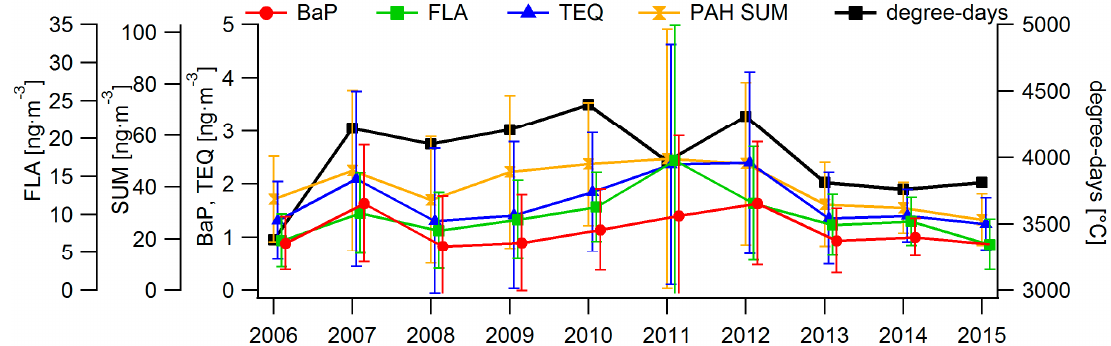
Figure 2. The degree-days and medians (± standard deviation) of BaP, TEQ, FLA, and PAH SUM concentrations in the cold half-year (October–March). The year 2006 stands for winter season 2006–2007, etc. The markers are shifted for better readability. FLA—representatives of “light PAHs” and indicators of local combustion effects, BaP—representative of “heavy PAHs” and a substance with threshold limit value (TLV), sum of all PAHs (PAH SUM)—indicators of total PAH pollution, and the toxic equivalency factor (TEQ)—a marker of toxic action, calculated according to [24].